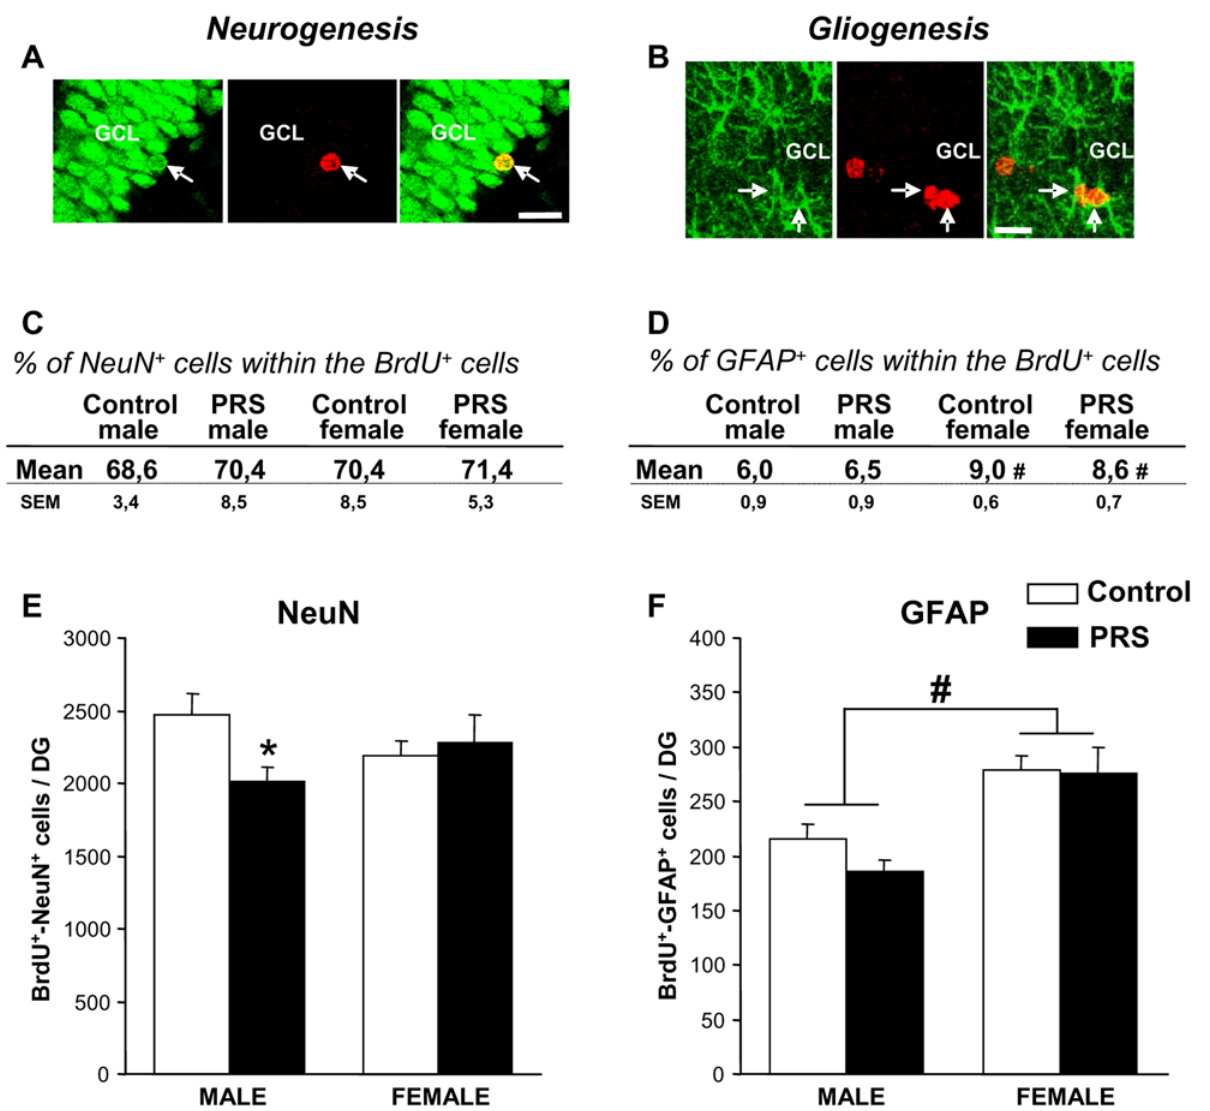
Figure 3. Hippocampal neurogenesis and gliogenesis in control and PRS rats. Representative confocal laser scanning microscope image showing cells double-labeled for BrdU (red nuclear staining) and the neuronal marker NeuN (green nuclear staining) (A), and cells double-labeled for BrdU and the glial marker GFAP (green cytoplasmic staining) (B). DG: dentate gyrus; GCL: granular cell layer; arrows: double labeled cells. Scale bars- 20 m m. (C,D) PRS did not affect the percentage of NeuN + /BrdU + cells or the percentage of GFAP + /BrdU + cells within the total population of BrdU + cells in male and female rats. It is worth noting, however, that both control and PRS female rats showed more efficient gliogenesis, as reflected by a greater percentage of GFAP + /BrdU + cells than in male rats ( # p , 0.05 ANOVA sex effect: F (1,16) =6.48,). (E) PRS reduced the total number of BrdU + / NeuN + cells in male rats (* p , 0.05, ANOVA + Newman-Keul’s post-hoc test), with no effect in female rats. (F) PRS had no effect on astroglial differentiation; female rats, independent of group, showed an increase in the total number of newly-formed astroglial cells ( # p , 0.05, ANOVA sex effect: F (1,16) =4,53). Bars represent means 6 SEM (n=5 rats per group).